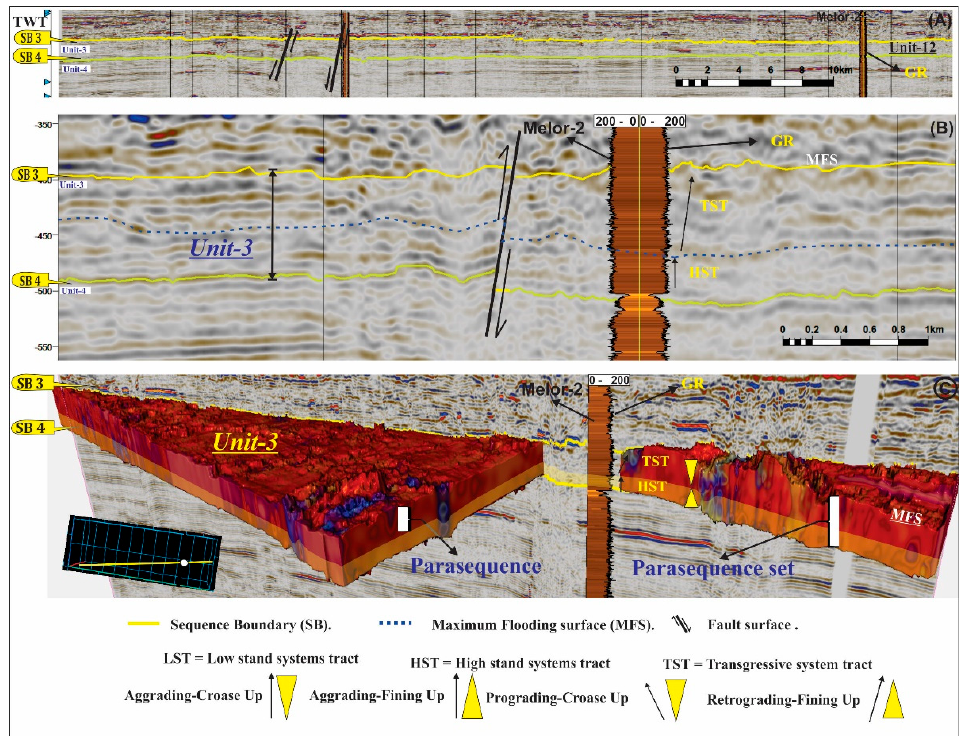
Figure 12. ( A ) A regional seismic cross-section of unit 3, ( B ) a detailed explanation of the sequence boundaries of unit 3, systems tract, and faults, and ( C ) the 3D visualization of unit 3 with system tract, parasequences, and parasequences set.